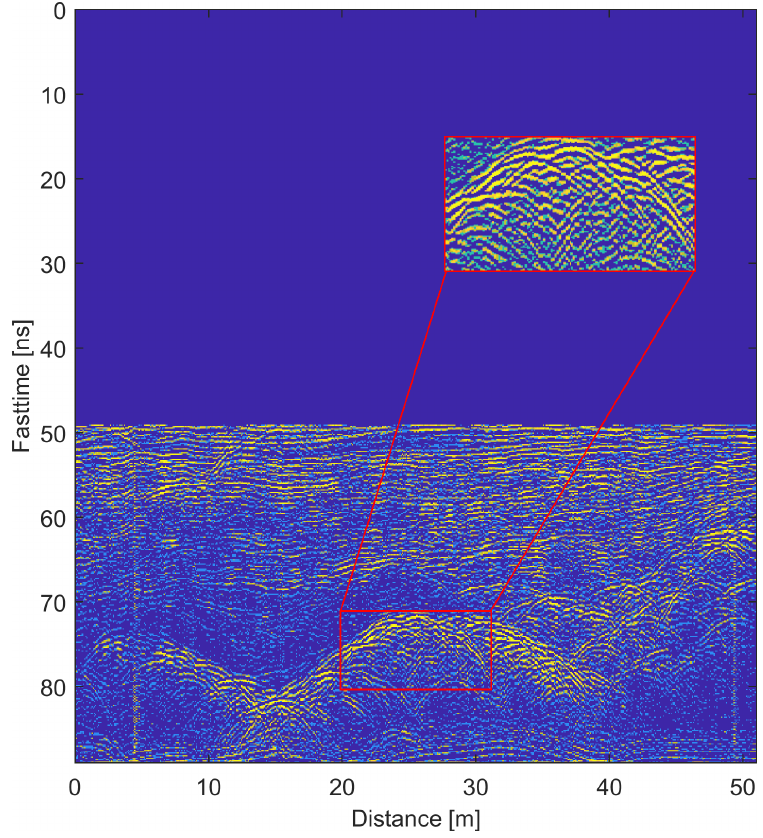
Figure 2. Example radar image of hyperbola segmenting and altitude correction.